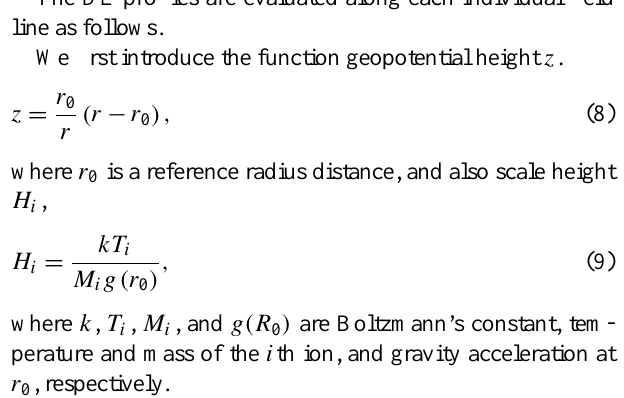
Figure 1a gives a view of the fixed longitude plane show- ing plasmapause location at L = 4 and indicating the starting points for the ray tracing of each chorus element. In accor- dance with the chorus equations (Omura et al., 2008, 2009), the generation point is at the magnetic equator for chorus ris- ing elements, and the initial frequency sweeps linearly with time from 0.2–0.4 (cid:127) e / 2 π (Hz) in 50 ms, where (cid:127) e / 2 π is the local electron gyrofrequency. The elements are repeated ev- ery 50 ms. The starting values for parameter L are L = 3 . 8 just inside the plasmapause, actually at the plasmapause L = 4, and outside the plasmapause L = 4 . 5. While it is true that most chorus originates outside the plasmapause, the ray trac- ing starting from L = 3 . 8 would be relevant to the closely al- lied problem of discrete and triggered VLF emissions. All ray tracing starts with zero propagation angle, or k vector paral- lel to B 0 (z) , on the grounds that parallel propagation cor- responds to maximum instability and observations (Santolik and Gurnett, 2003; Santolik et al., 2003, 2009) point to par- allel or quasi-parallel propagation at the point of